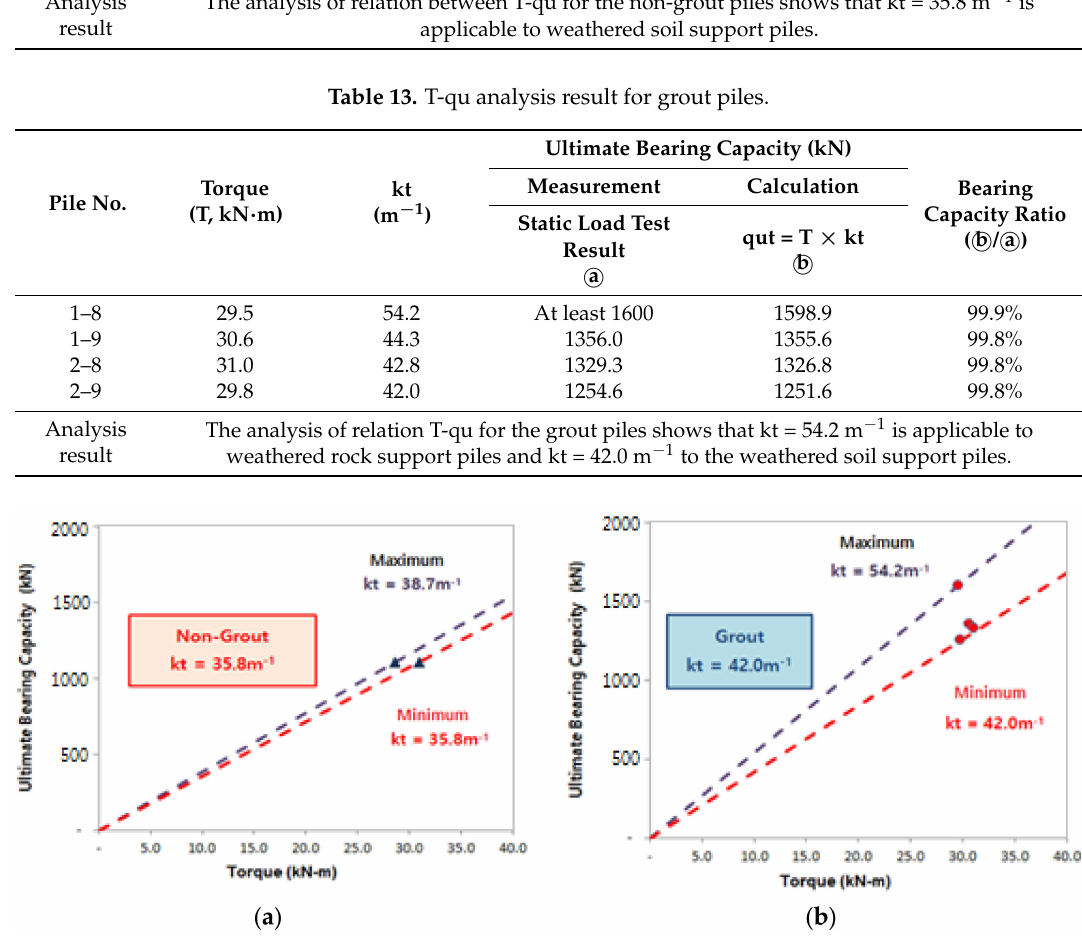
Figure 9. Results of the analysis of the relation between torque (T)–ultimate bearing capacity (qu): ( a ) Non-grout pile; ( b ) Grout